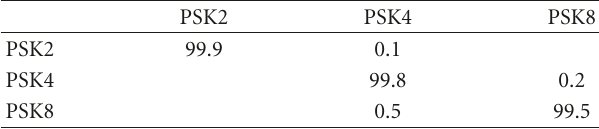
Table 8: Confusion Matrix at SNR = 4d